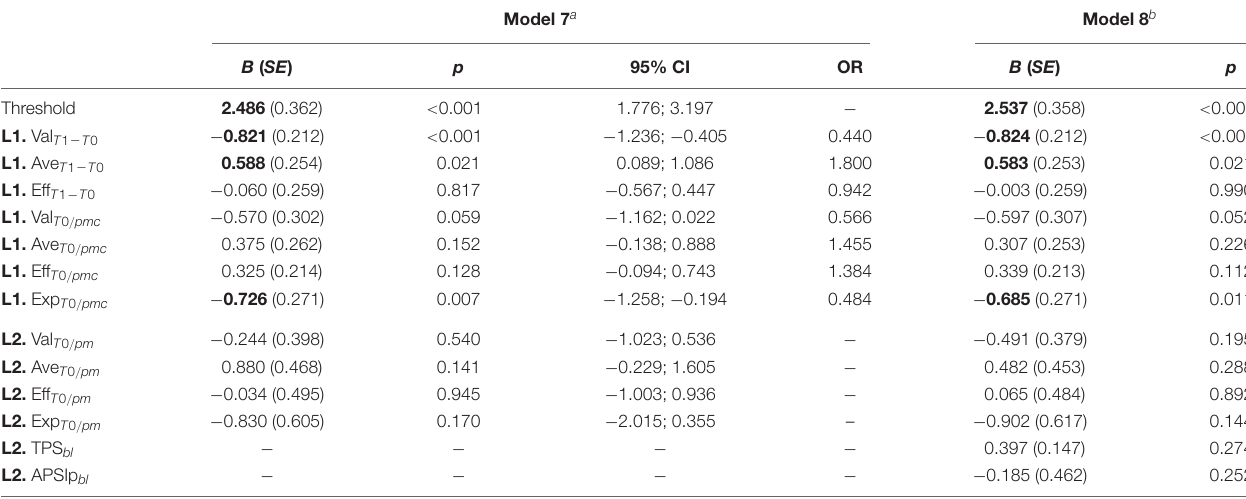
TABLE 6 | Combined multi-level-models predicting the risk to delay ( Y = 1) vs. work on a task ( Y = 0), based on initial task-specific assessments (T0) and change indicators